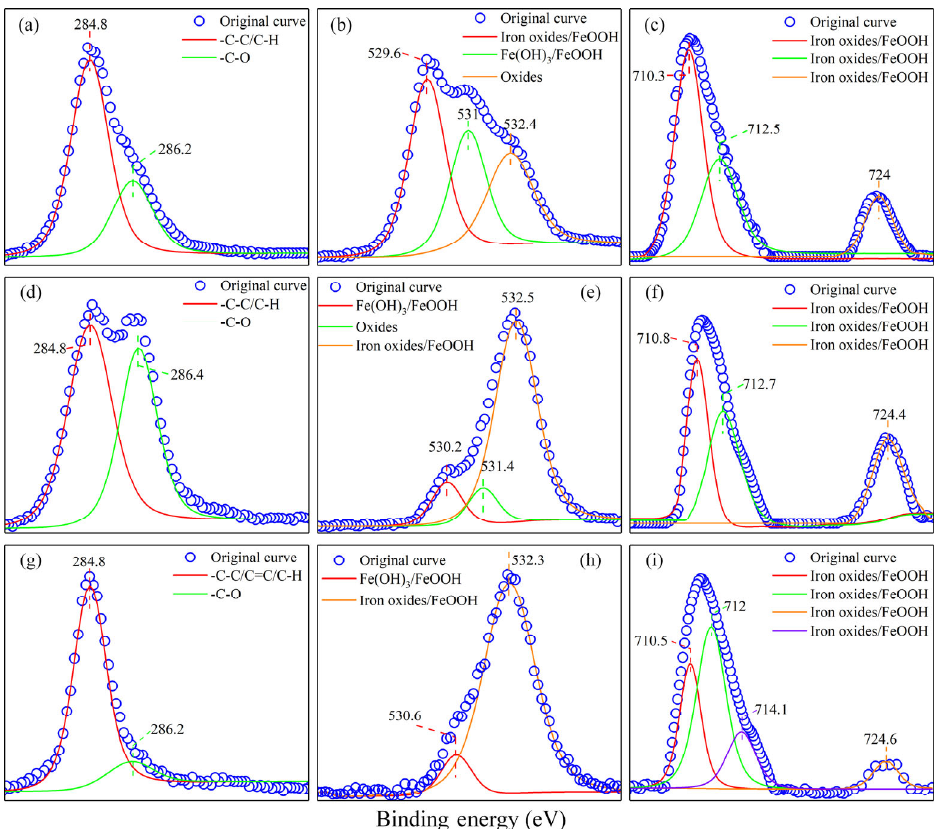
Fig. 4 XPS results for the worn regions on the steel ball after being (a–c) lubricated with PEG(aq): (a) C 1s, (b) O 1s, and (c) Fe 2p3; (d–f) lubricated with PAG100 (the friction pairs were treated by PEG(aq)): (d) C 1s, (e) O 1s, and (f) Fe 2p3; and (g–i) lubricated with PAO6 (the friction pairs were treated by PEG(aq)): (g) C 1s, (h) O 1s, and (i) Fe 2p3. The normal load and sliding velocity were 3 N and 0.1 m/s,